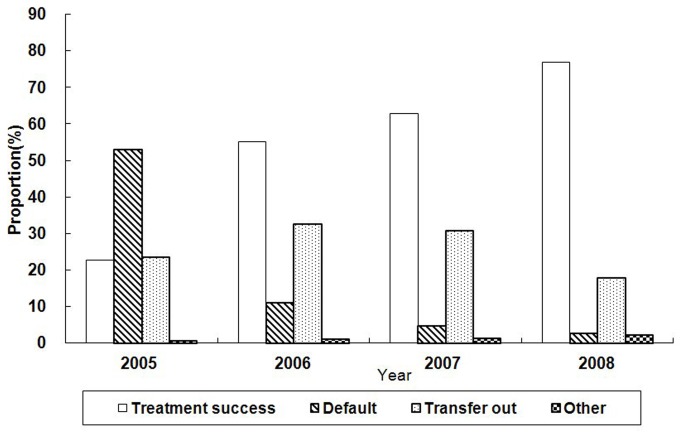
Treatment outcomes of active TB patients among urban migrants in Shanghai, 2005-2008.The average treatment success and default rates during 2005 to 2008 were 55.2% and 16.8%, respectively. There was an increasing trend for treatment success from 2005 to 2008.